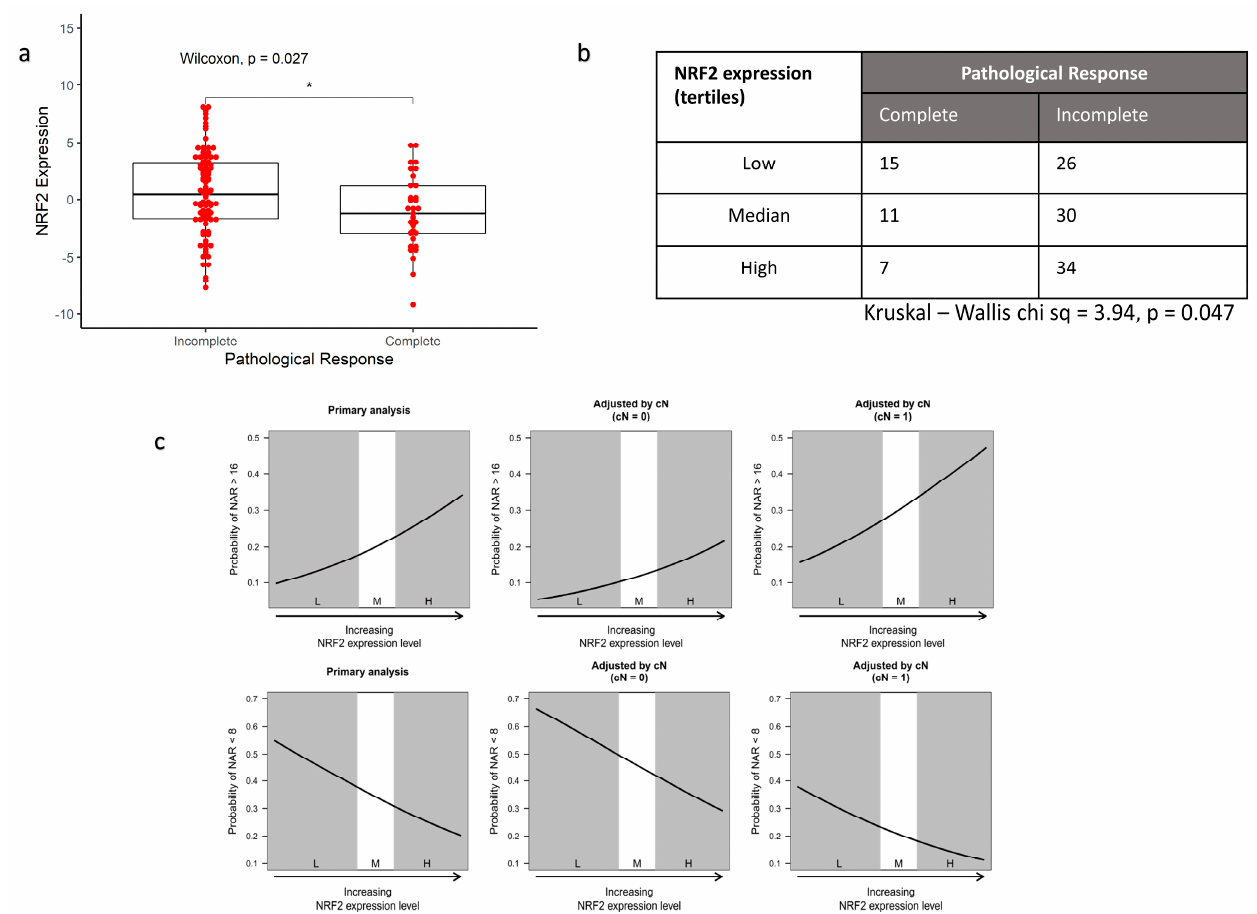
Figure 4. High NRF2 expression in baseline biopsies is associated with worse tumour response in patients (N = 123). ( a ) Boxplot comparing mean NRF2 signature expression between patients who achieve a complete pathological response and those who have residual disease following radiation; ( b ) count table showing a significantly higher proportion of patients with the highest tertile of NRF2 signature expression have a worse response to radiation; ( c ) ordinal logistic regression plots for NRF2 expression predicting NAR score. Upper row: Probability of an NAR > 16. As NRF2 expression increases, the odds of a high NAR score increase. The effects of including clinical nodal stage from the MRI on the model are also shown. Clinical nodal stage is the only clinical factor that is not part of the NAR score. Node positivity at baseline and high expression of NRF2 signature has much greater odds of a high NAR score. Lower row: Probability of NAR < 8. As NRF2 expression increases, the odds of low NAR score decrease. Adjustments for cN stage are also shown. (L, M, H are tertiles of NRF2 signature expression where L = lowest/bottom tertile; M = median tertile; H = highest tertile) (* signifies p <